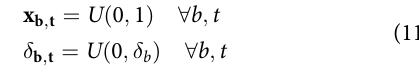
Figure1 wasgeneratedusingtheformulationsinequations(11) and (12). A value x b,t is randomly generated between 0 and 1 for each boiler and each